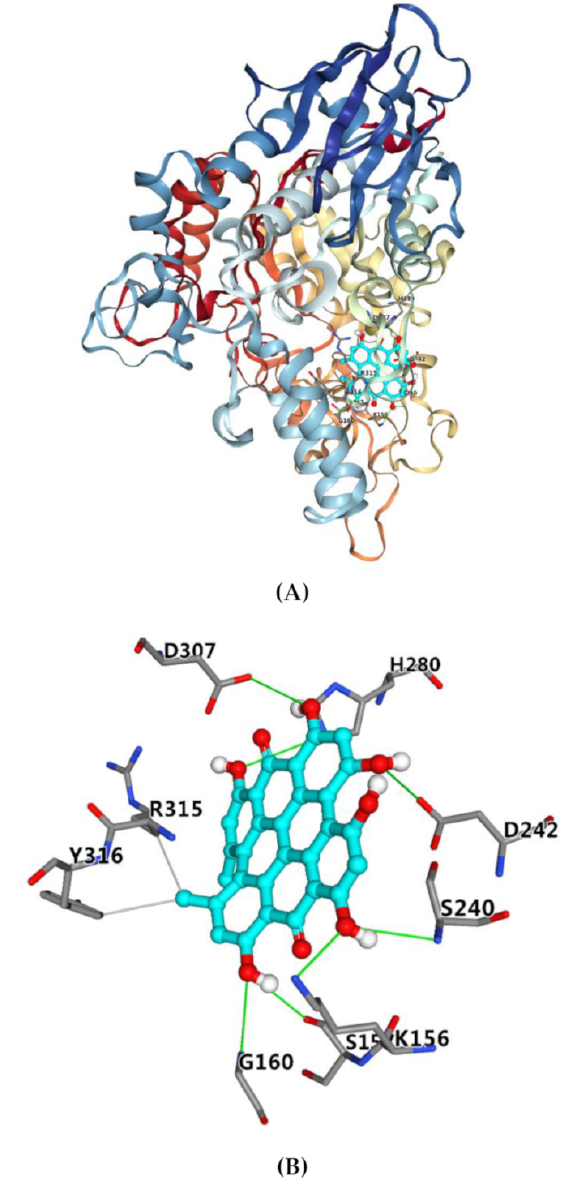
Figure 3. The molecular docking result of hypericin on α -glucosidase ( A ); the interaction of hypericin with the key residues in the active cavity of α -glucosidase ( B